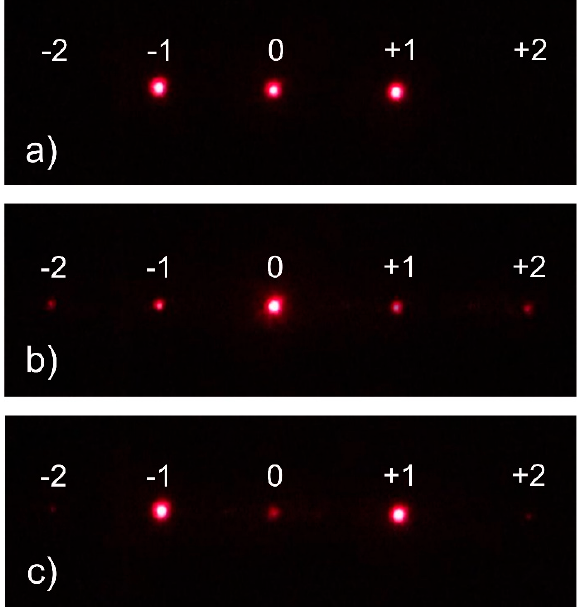
Figure 3. Diffraction patterns observed for the linearly polarized 690 nm beam incident onto LC_1 cell at ( a ) 0 V, ( b ) 1.35 V, ( c ) 2.2 V.